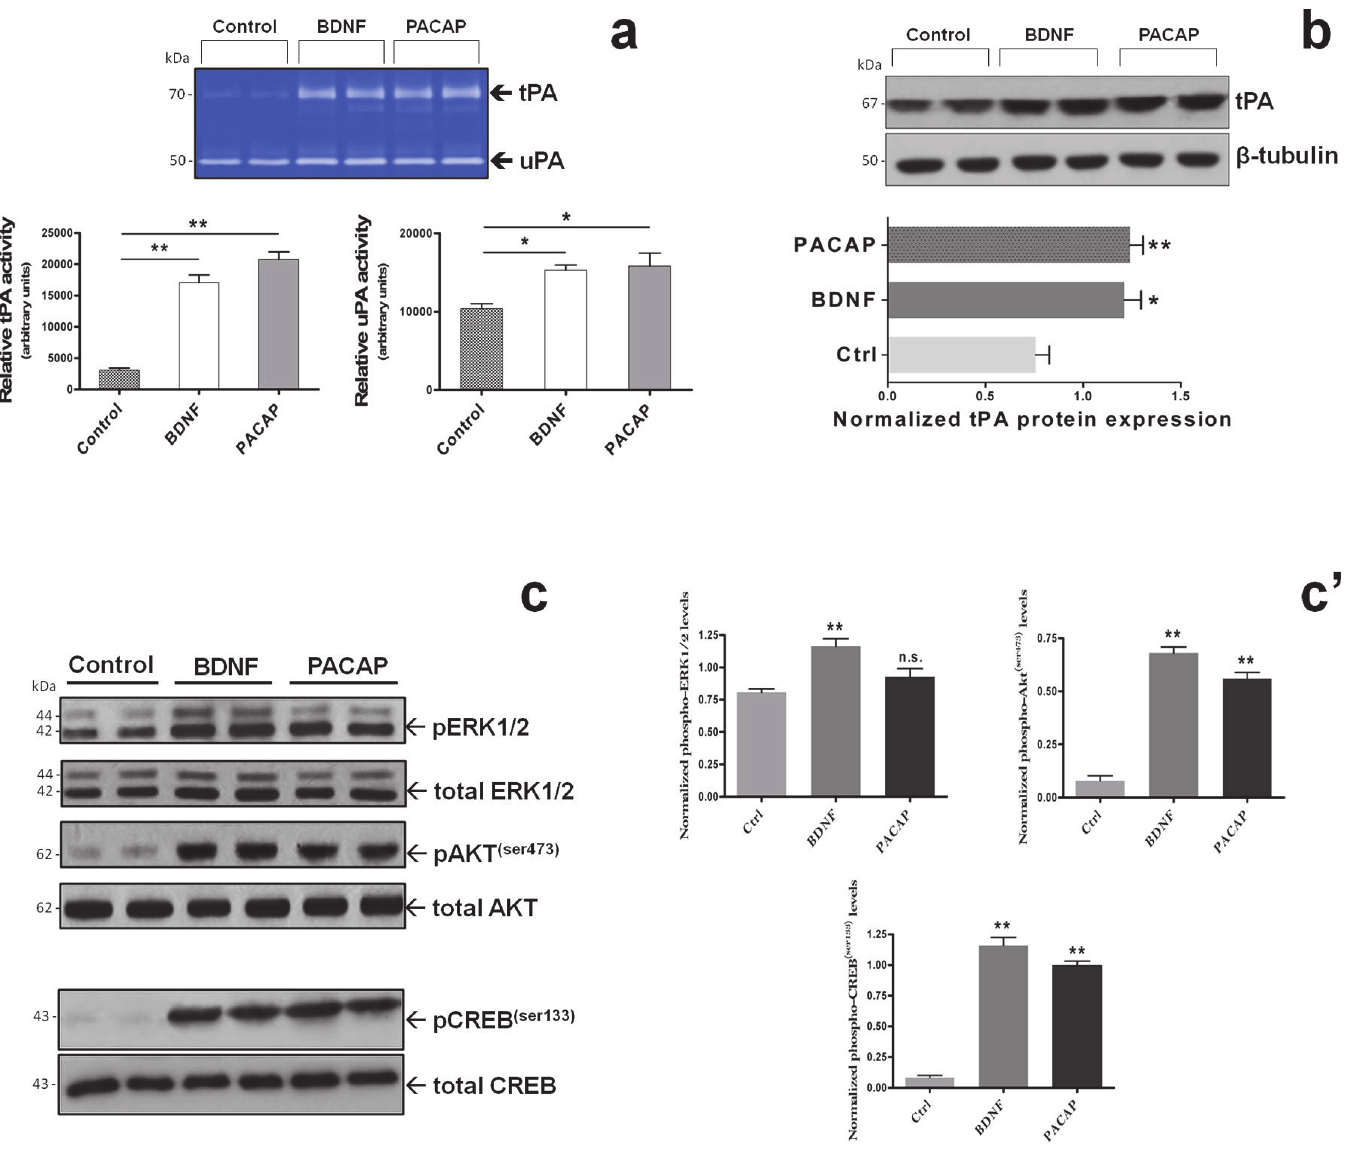
Fig. 3. PACAP- and BDNF-mediated induction of tPA expression and activity involves both the MAPK Erk1/2 and Akt/cAMP-responsive element binding protein (CREB) signaling pathways. Representative zymographic ( a ) and Western blot analyses ( b ) demonstrating the effects of 10 − 7 M PACAP or 2x10 − 9 M BDNF treatment on tPA and uPA activity ( a ) and tPA protein expression ( b ) in RT4-D6P2T cells after 24h. tPA and uPA activities were determined by zymography as detailed in MATERIALS AND METHODS. The representative picture shows lytic areas (white bands) on a Coomassie-stained gel (blue background) that correspond to the predicted molecular weight for tPA (64-70kDa) and uPA (~50kDa). Bar graphs depicted below the gel indicate the relative activity of each plasminogen activator, measured as the mean band intensity obtained from at least three separate determinations and calculated using the ImageJ software. * p < 0.05 or ** p < 0.01 Vs Control ; ANOVA followed by Dunnett ’ s post-hoc test. ( c and c ’ ) Activation of the MAPK Erk1/2 and Akt/CREB signalling cascades was assessed by measuring Erk1/2, Akt and CREB phosphorylation at the indicated phospho-sites using the same procedures described in Fig. 1. Relative activation was calculated by normalizing each phospho-protein level over the corresponding unphosphorylated protein, which also served as loading control. Each plotted result represents the mean ± SEM from three separate experiments. ** p < 0.01 Vs Control ; ANOVA followed by Dunnett ’ s post-hoc test. n.s. = not